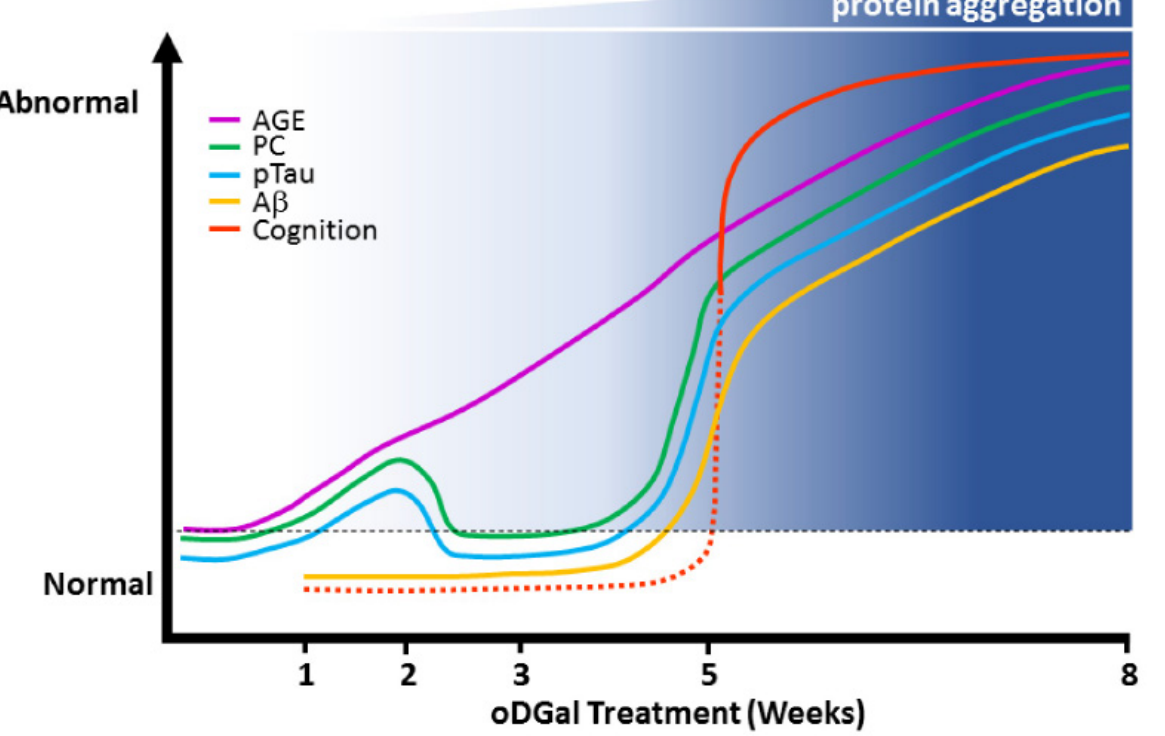
Figure 8. Diagram illustrating sequential onset of pathologies in the hippocampus following oDGal dosing. Spatial cognitive deficit precipitates at 5 weeks and correlates negatively with elevated AGE and PC. AGE, PC, p-tau, and A β levels are all elevated in the soluble fraction of the hippocampus following 5 weeks of dosing. At the 8 week time point, these pathologies undergo significant aggregation and propagate to adjacent brain regions such as the cortex, frontal cortex, and cerebellum. With specific respect to nuances in AD-related pathophysiology, our cognitive data suggested that the perirhinal cortex was affected prior to the hippocampus following oD- Gal exposure, as animals dosed for 8 weeks with 2 g/kgoDGal were able to perform the hippocampal driven NOL task (Figure 5F) but were impaired in the perirhinal cortex-de- pendent NOR task after just 2 or 4 weeks of dosing (Figure S2A,B). These data share sim- ilarities with clinical observations, where the perirhinal/entorhinal cortex is affected early in the disease course and prior to detrimental alterations occurring at the level of the hip- pocampus [47–50]. The pathology displayed in the AD brain is multifaceted, and pathological spreading is a key feature of the disease [51]. Tg animal models of AD possess an applied develop- mental phenotype dependent on the overexpression of mutant proteins, which ultimately affects pathology initiation and progression timing. Although the amyloid cascade hy- pothesis has been proposed to be responsible for the pathogenesis of fAD, increasing evi- dence suggests that dysregulated cellular metabolism and oxidative stress play a key role in the etiology of sAD [3,52]. Abnormal levels of oxidative stress markers have been re- ported in sAD patients [53,54] and precede A β accumulation by decades [55–57]. Further- more, FDG-PET imaging data clearly demonstrates significant hypometabolism in brain regions affected by AD decades before the disease may become apparent [58]. Neuromet- abolic dysfunctions (potentially linked to multiple glycometabolic deficits) are highly likely to result in the exacerbation of oxidative stress as ROS are found to be elevated in pro-diabetic states linked to dementia [59–61]. Increased oxidative stress has also been strongly associated with the excessive generation of AGE products. AGE products are